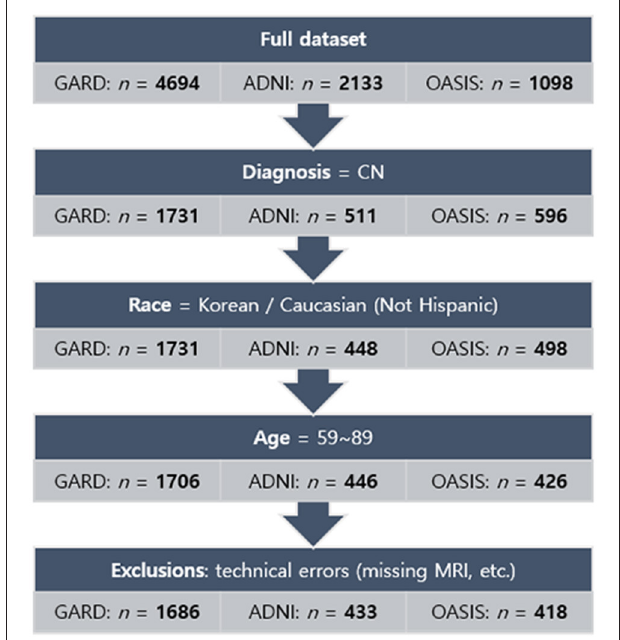
FIGURE 1 | Flowchart of the process of subject selection for the norms. The normative sample finally comprised 2,537 subjects: 1,686 for Koreans and 851 for Caucasians. GARD, Gwangju Alzheimer’s and Related Dementia. ADNI, Alzheimer’s Disease Neuroimaging Initiative. OASIS, Open Access Series of Imaging Studies.